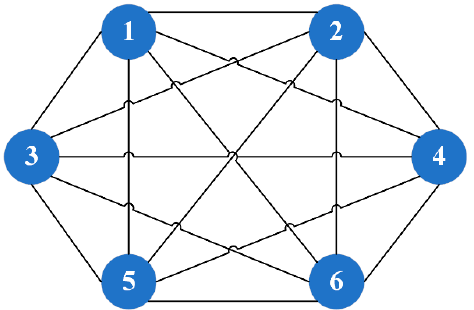
Figure 4. An example of six DG units connected based on complete communication topology.